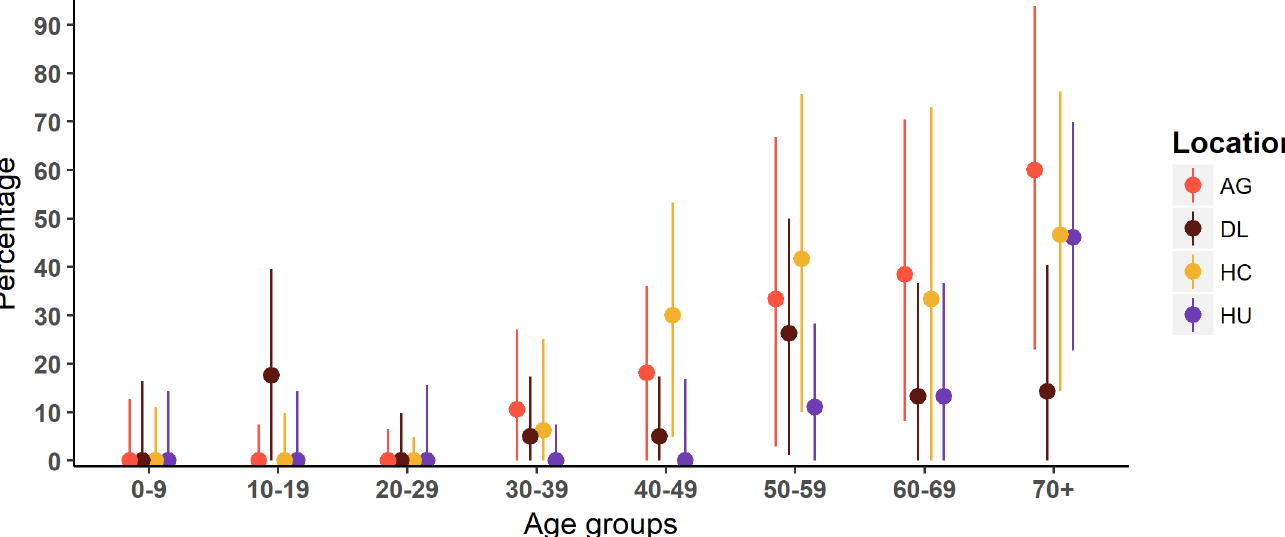
Fig 4. Percentage of positive individuals and the binomial proportion confidence intervals by age group in each location: The binomial 95% confidence intervals are corrected by known 90% sensitivity and 90% specificity of the diagnosis test [69]. The colors represent each location, with red for An Giang province, brown for Dak Lak province, orange for Ho Chi Minh City, and purple for Hue City.